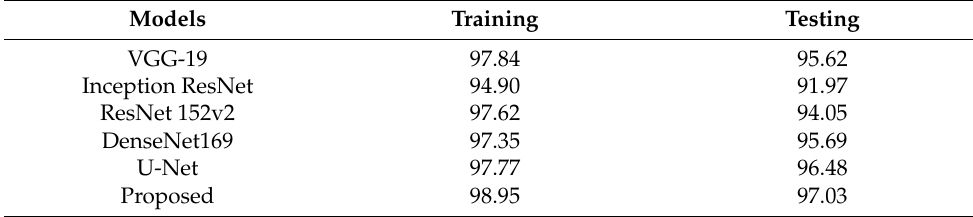
Table 3. Evaluation of the effectiveness of recall.